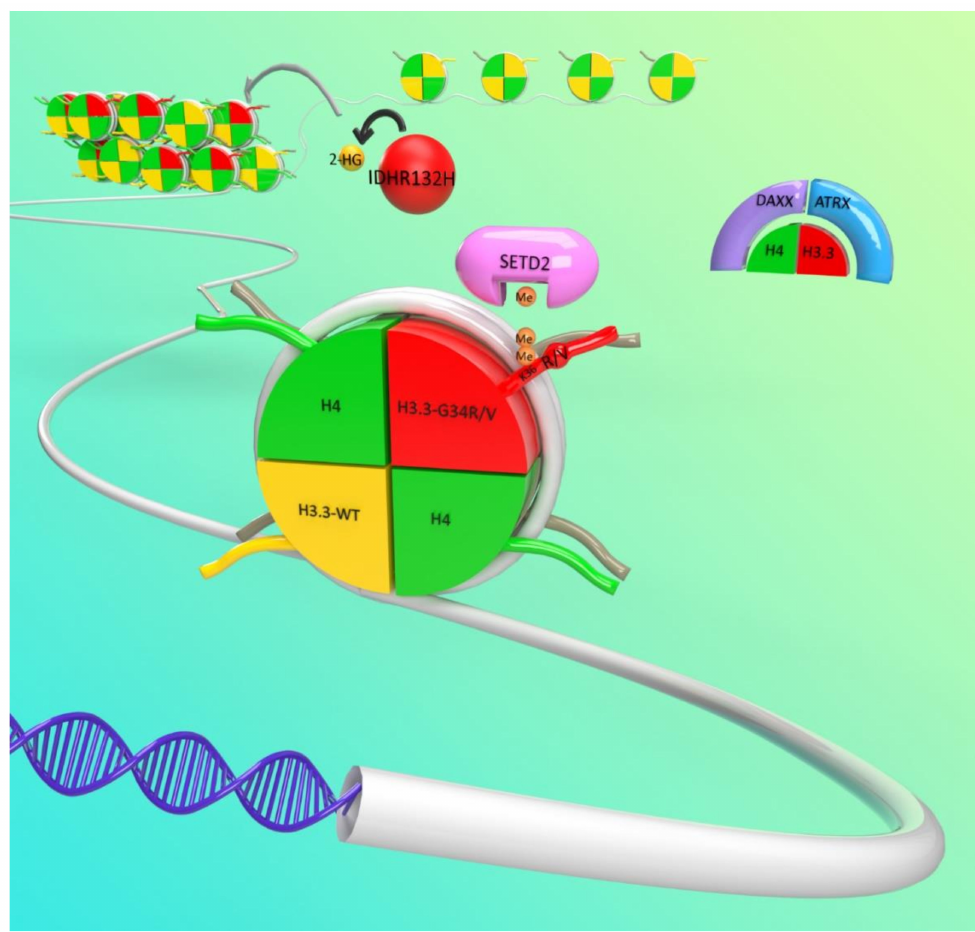
Figure 2. Illustration depicting the most prominent epigenetic alterations in hemispheric pediatric high grade glioma (pHGG): The most common epigenetic alterations are H3F3A-G34R / V (Glycine to Arginine or Valine mutations in Histone H3.3) mutations and ATRX (thalassemia / mental retardation syndrome X-linked) loss-of-function mutations. Less frequently, mutations on SET Domain Containing 2 protein (SETD2), an H3K36me3 writer, Death domain-associated protein (DAXX), part of the ATRX / DAXX complex, and Isocitrate dehydrogenase 1 (IDH1), among others, also act as epigenetic disruptors. IDH1 gain of function mutations lead to the production of 2-hydroxyglutarate (2-HG), which inhibits histone and DNA